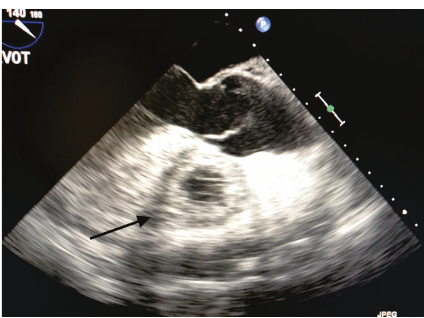
Figure 3: Transesophageal echocardiogram with TG SAX view showing extensive thrombus formation in the right